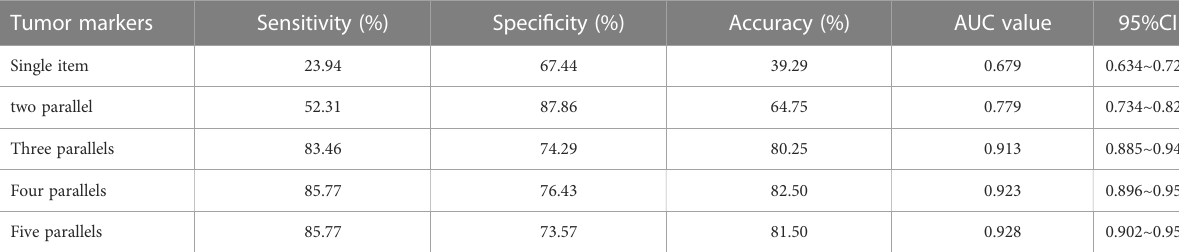
TABLE 4 Diagnosis results of fi ve tumor markers in different parallel ways (%).